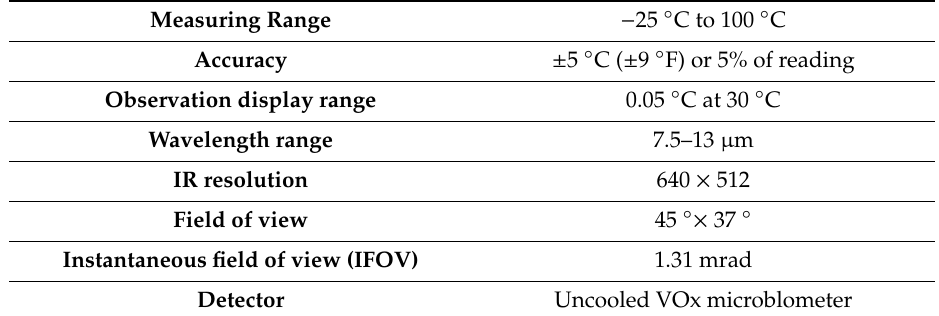
Table 3. Specification of the IR camera (FLIR A65).